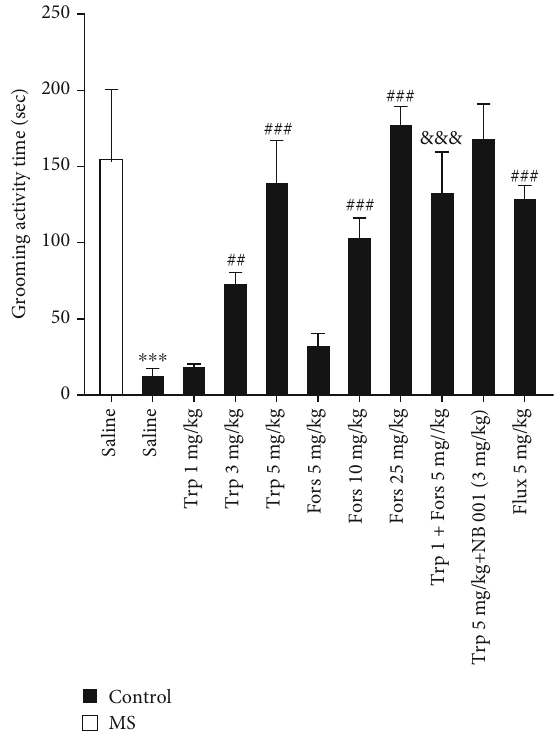
Figure 3: Grooming activity time in the splash test. Values are presented as the mean ± S : E : M : from 6 animals and were analysed using one-way ANOVA followed by Tukey ’ s post test. Drugs were dissolved in physiological saline and injected as a single dose via intraperitoneal (i.p.) route with a volume of 5ml/kg body weight one hour before the test. ∗∗∗ P < 0 : 001 compared with the saline- treated control group, ## P < 0 : 01 and ### P < 0 : 001 compared with the saline-treated MS group, and &&& P < 0 : 001 compared with the tropisetron- (1 mg/kg) received MS group. MS: maternal separation; Trp: tropisetron; Flux: fl uoxetine; Fors: